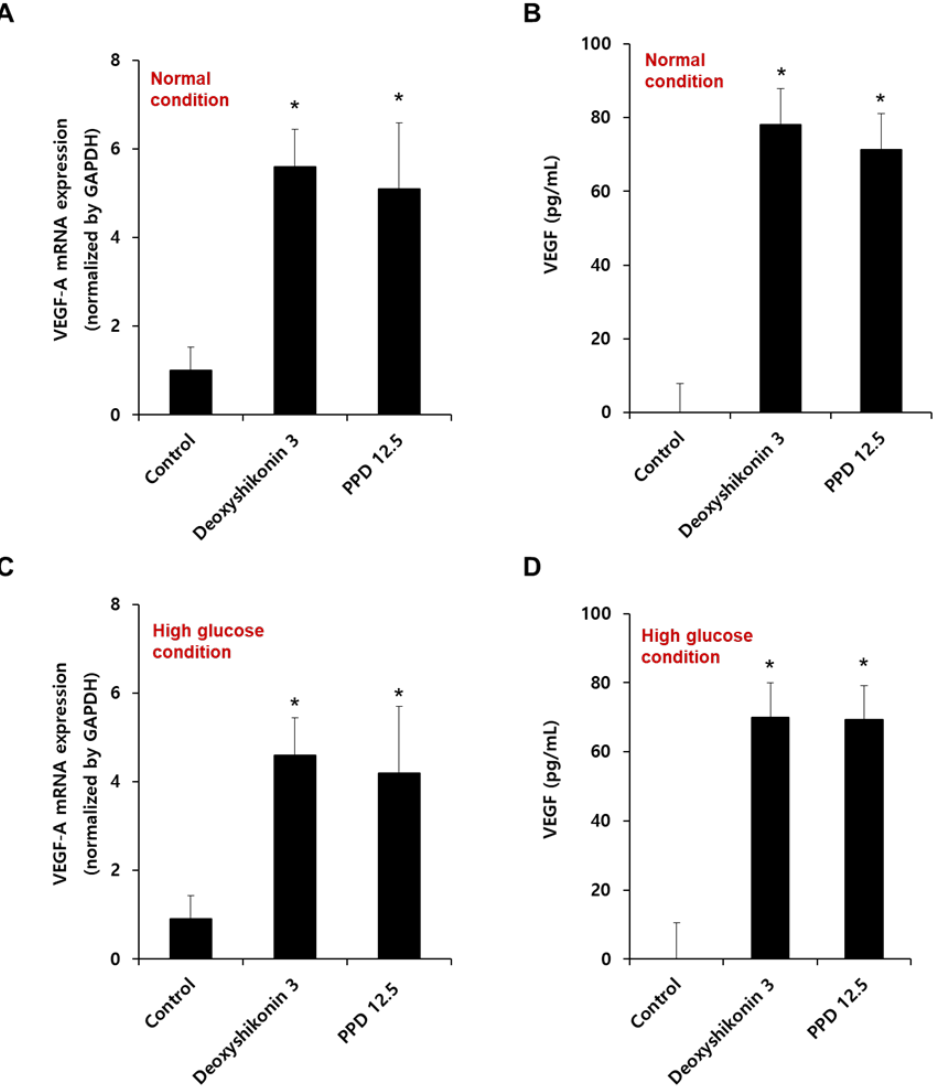
Figure 7. Effect of PPD on the mRNA expression and cytokine production of VEGF in HUVECs. ( A , C ) Cells (8 × 10 5 cells/6-cm dish) were stimulated with deoxyshikonin (3 µ M) or PPD (12.5 µ M) for 12 h under normal or high glucose conditions. The mRNA expression of VEGF-A was checked using qRT-PCR with specific VEGF-A primers. Deoxyshikonin (3 µ M) was used as a positive control for VEGF-A gene expression. GAPDH gene was used as a housekeeping gene for normalization. ( B , D ) Cells were stimulated with deoxyshikonin (3 µ M) or PPD (12.5 µ M) for 24 h in normal or high glucose conditions. The cell supernatant was collected, and VEGF secretion was measured by a commercial ELISA kit. Data are presented as the mean ± standard deviation (SD) of three independent experiments. * p < 0.05 compared to the